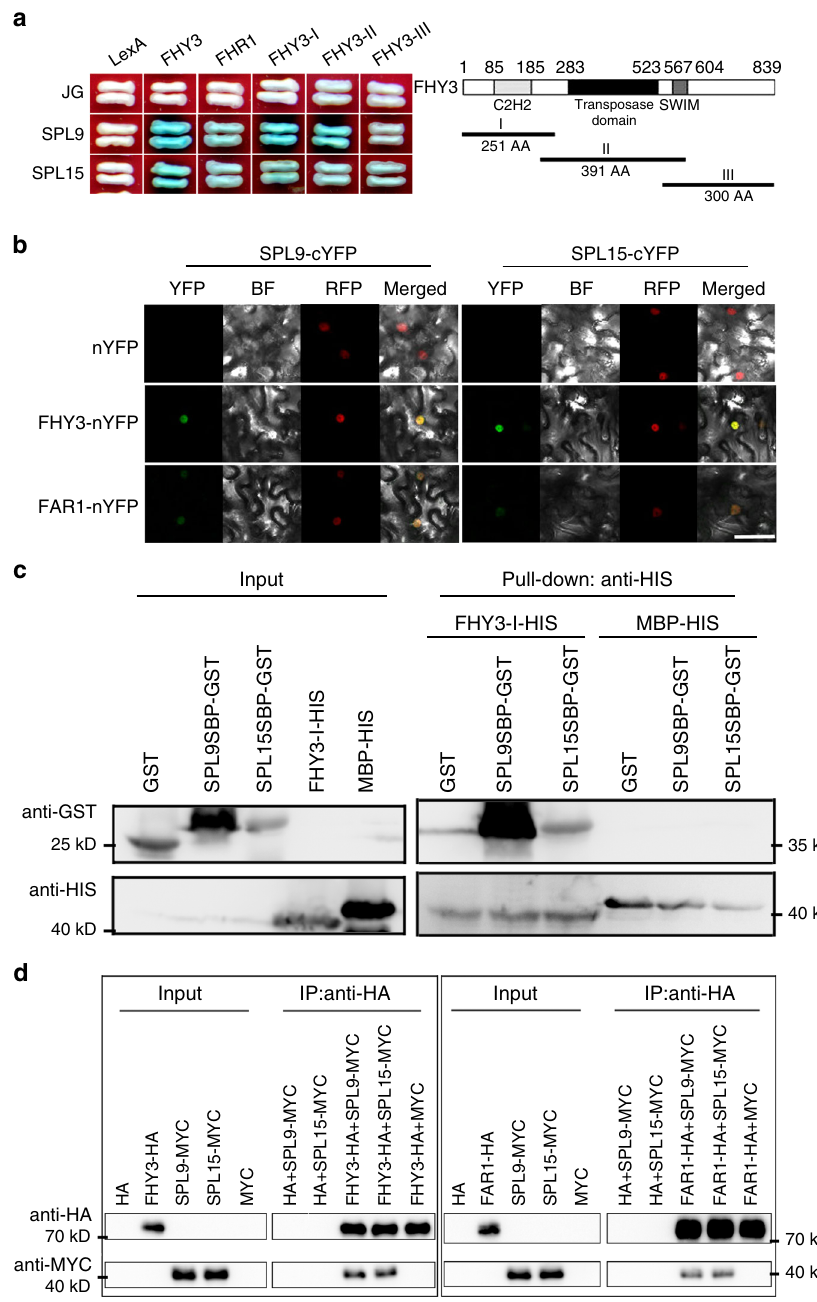
Fig. 3 FHY3 and FAR1 directly interact with SPL9 and SPL15. a Yeast two-hybrid assay shows that both SPL9 and SPL15 interact with FHY3 and FAR1. LexA and JG serve as the negative controls. b BiFC assay shows that both SPL9 and SPL15 interact with FHY3 and FAR1 in N. benthamiana leaf epidermal cells. Both FHY3 and FAR1 were fused to the N-terminal fragment of YFP (nYFP) and both SPL9 and SPL15 were fused to the C-terminal fragment of YFP (cYFP). The AT-HOOK-RFP marker was used to indicate the nuclei. The interaction between nYFP and SPL9-cYPF or SPL15-cYPF serves as the negative controls. Scale bar = 50 μ m. c Pull-down assay shows that FHY3 directly interacts with both SPL9 and SPL15 in vitro. GST-SPL9SBP or GST-SPL15SBP proteins were incubated with protein extracts containing His-FHY3-I and further immobilized with glutathione sepharose beads. d Co-IP analysis shows the interaction between FHY3/FAR1 and SLP9/15 using a transient expression system in tobacco leaves. Immunoprecipitation was performed using anti-HA matrix and the co-immunoprecipitated proteins were detected with anti-MYC antibodies. This assay was repeated for three times and similar results were